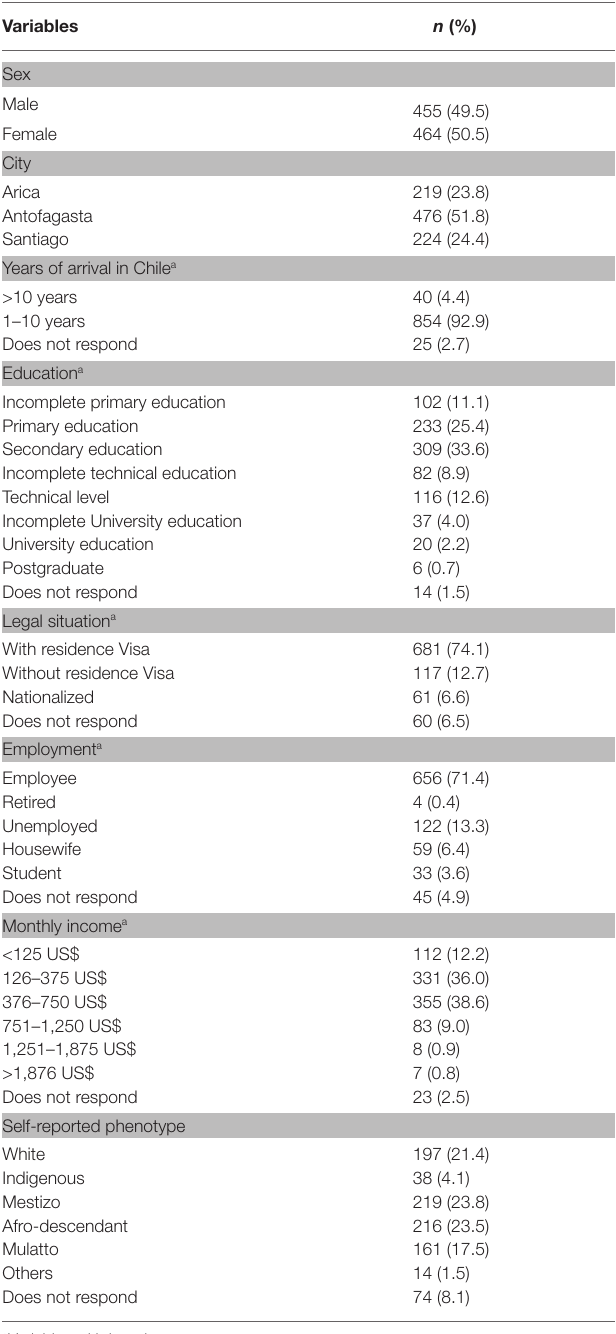
TABLE 1 | Sociodemographic characteristics of